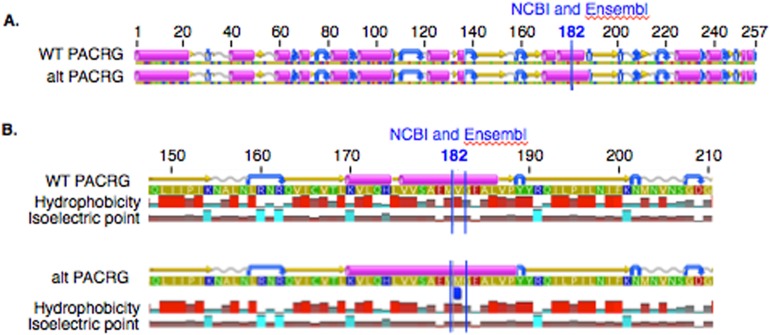
Alignment of wild type (WT) and mutant (mut) PACRG proteins with associated predicted hydrophobicity and isoelectric point.Low (A) and high magnification (B) of predicted protein changes. Replacement of methionine for valine at position 182 changes a beta strand to an alpha helix at position 187 and 188. Alpha helices (pink), coils (gray line), turns (blue arrows), and beta strands (yellow arrows).